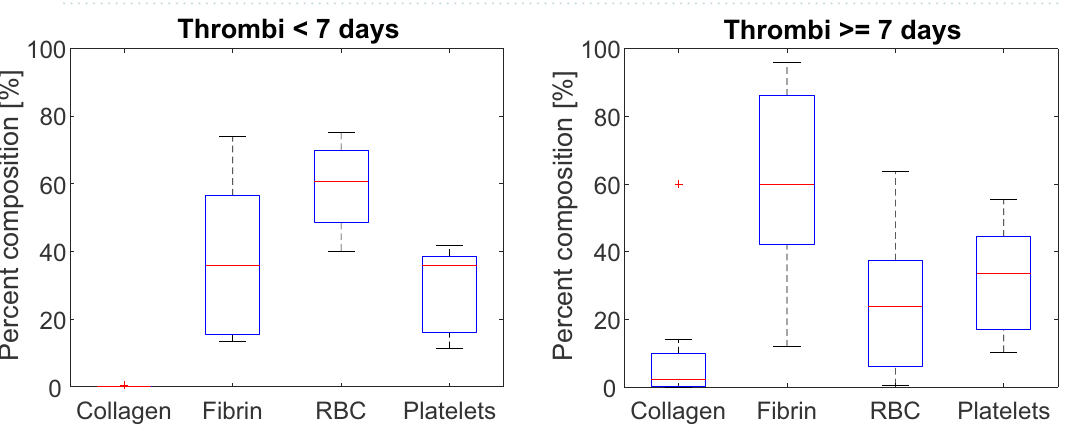
Figure 4. Histological analysis for acute (less than 7 days old, N = 12) and chronic (greater than or equal to 7 days old, N = 14) thrombi. None of the 26 samples were excluded from analysis. Red crosses indicate outliers and horizontal red lines indicate median values. The top and bottom portions of the blue box represent the 25th and 75th percentiles, respectively, and whiskers extent to the data points not considered outliers. Outliers correspond to datapoints greater than q 75 + 1.5 × (cid:31) q 75 − q 25 (cid:30) or less than q 25 − 1.5 × (cid:31) q 75 − q 25 (cid:30) , where q 25 corresponds to the 25th percentile of the sample data, and q 75 corresponds 75th percentile of the sample data 37